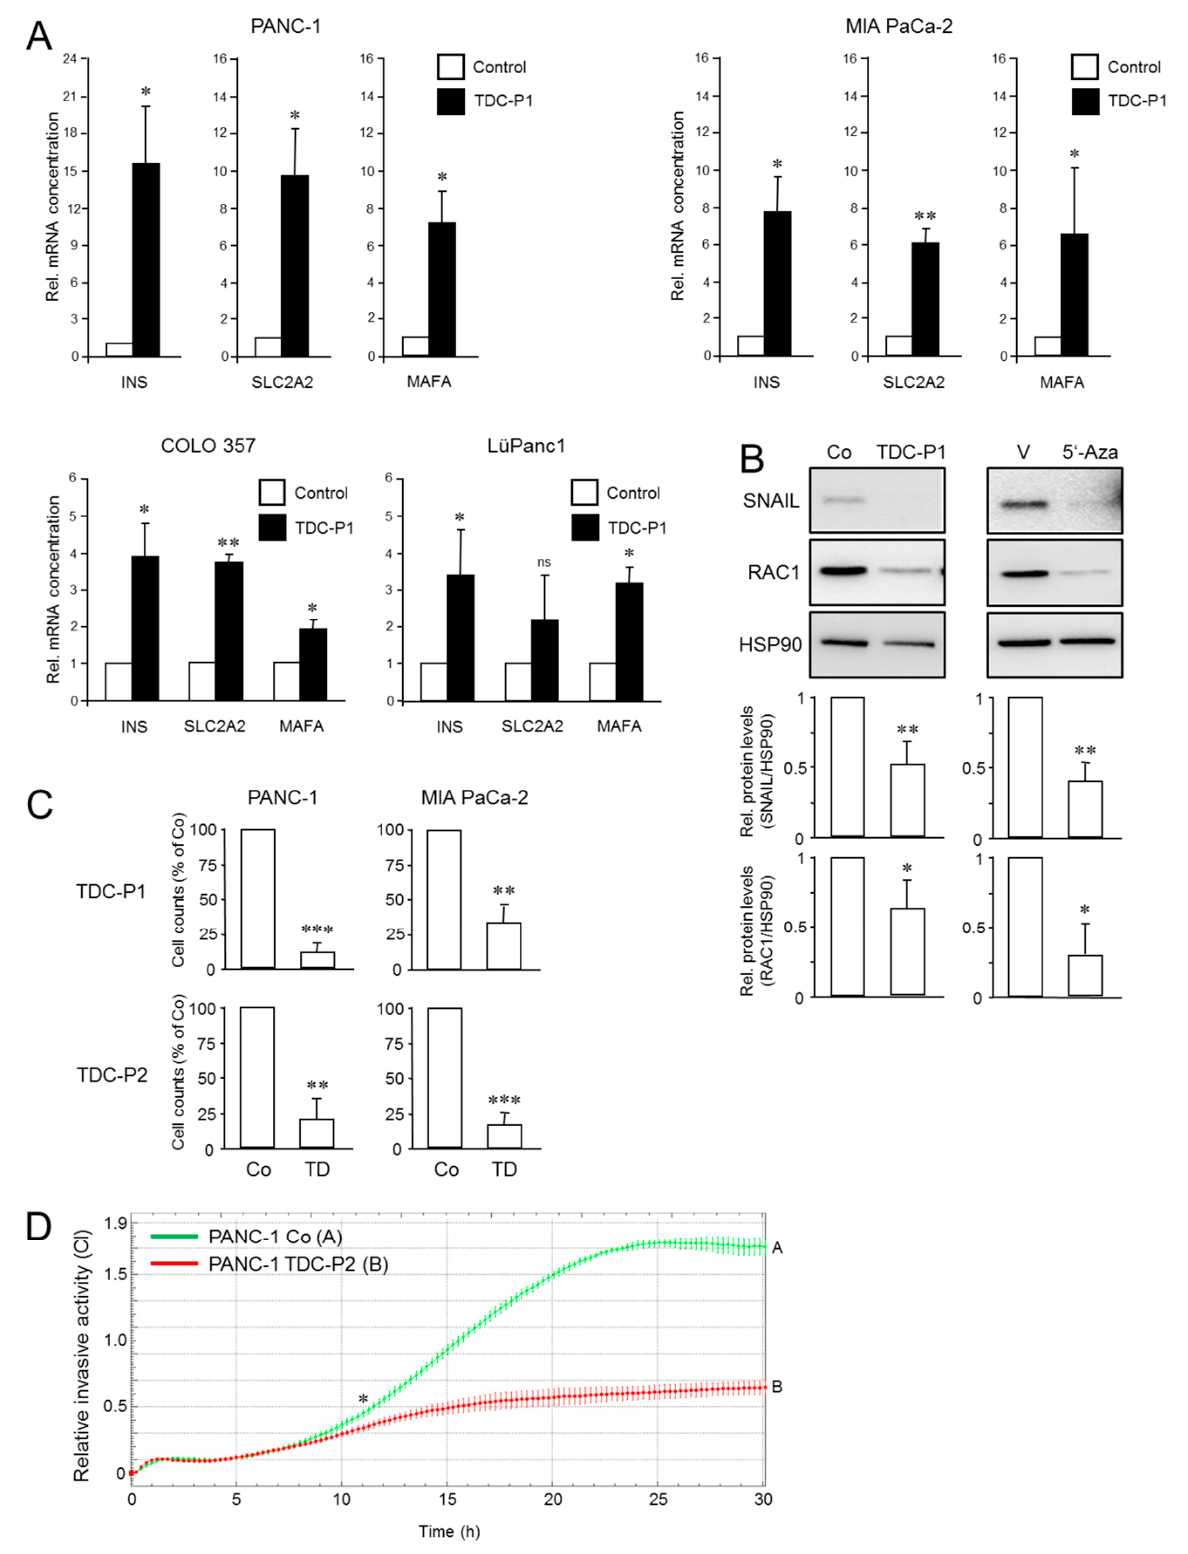
Figure 4. In vitro TD of established and primary pancreatic ductal epithelial cell lines to β cell-like cells. ( A ) PANC-1, MIA PaCa-2, COLO 357, and LüPanc1 cells underwent TD with FGF-b and transferrin (TDC-P1) for 5 d and after RNA isolation were monitored by qPCR for the induction of genes that specify mature functional β cells ( INS , SLC2A2 , MAFA ). The induction of SLC2A2 in LüPanc1 cells missed statistical significance (ns). Data represent the mean ± SD of three independent experiments ( n = 3). Asterisk, * p < 0.05, Wilcoxon test. Please note the different scales on the ordinates when comparing mRNA levels among the various cell lines. ( B ) Immunoblot analysis of SNAIL and RAC1 in protein lysates sampled from PANC-1 cells at the end of TDC-P1 or treatment with 5 ′ -Aza. Detection of HSP90 served to verify equal gel loading. The graphs underneath the blots show results from densitometry-based quantification of band intensities (mean ± SD, n = 3). Co, control culture. ( C ) Effect of ductal-to-endocrine TD on cell proliferation. PANC-1 and MIA PaCa-2 cells first under- went TDC with either P1 (for 3 d rather than the usual 5 d to avoid density-mediated growth arrest of control cells) or P2